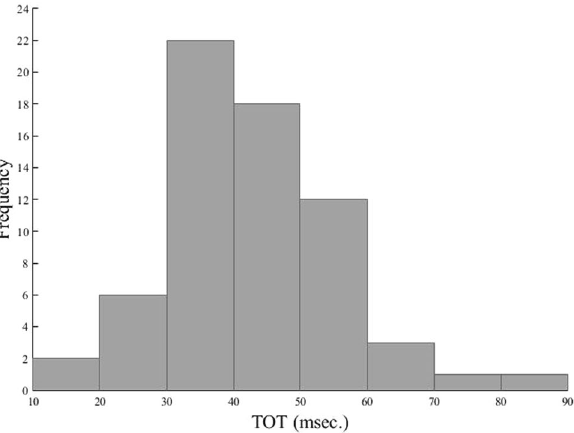
Figure 1. The distribution of the temporal order threshold (TOT) values across all the participants (n = 65). The mean TOT value = 42.86 ms., Standard Deviation (SD) = 12.7 ms., the median TOT value = 44 ms. and the TOT range: 18.67–86.47 ms. The skewness = 0.94 and the kurtosis =